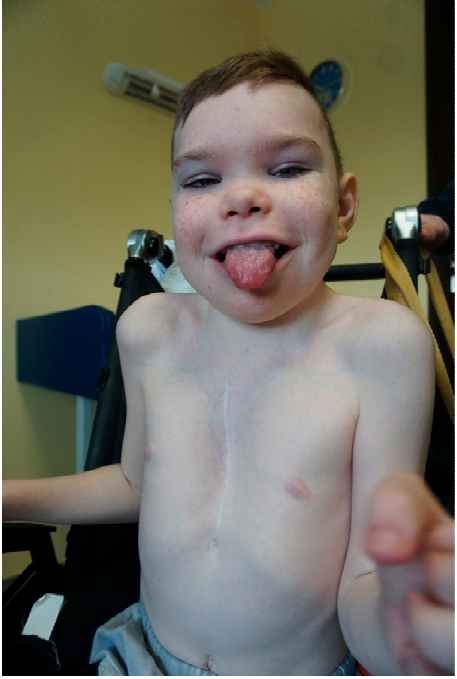
Figure 1. Features observed in the investigated subject.